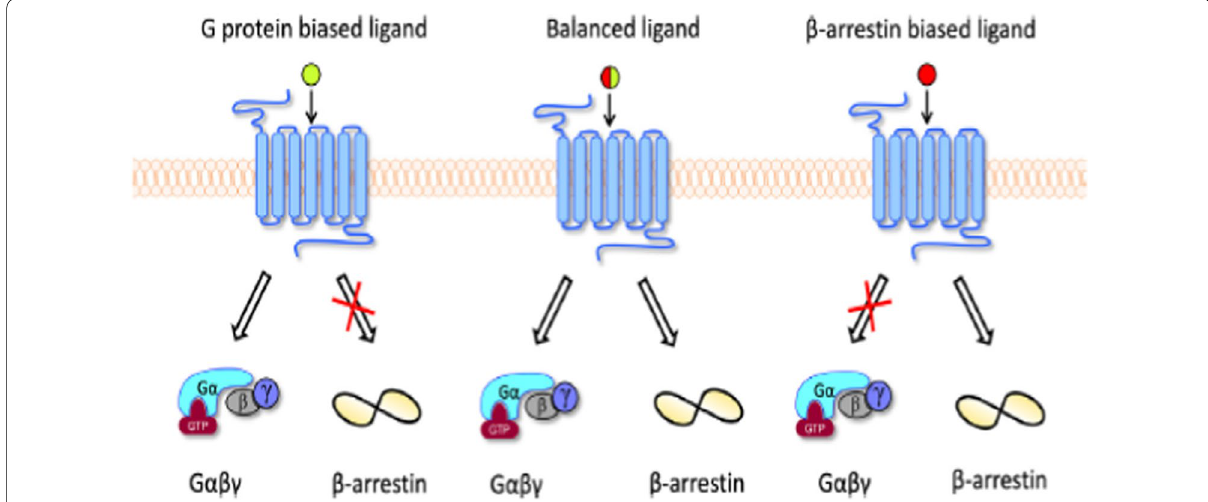
Fig. 3 Classical biased signalling for G protein and β-arrestin pathways in G protein-coupled receptors